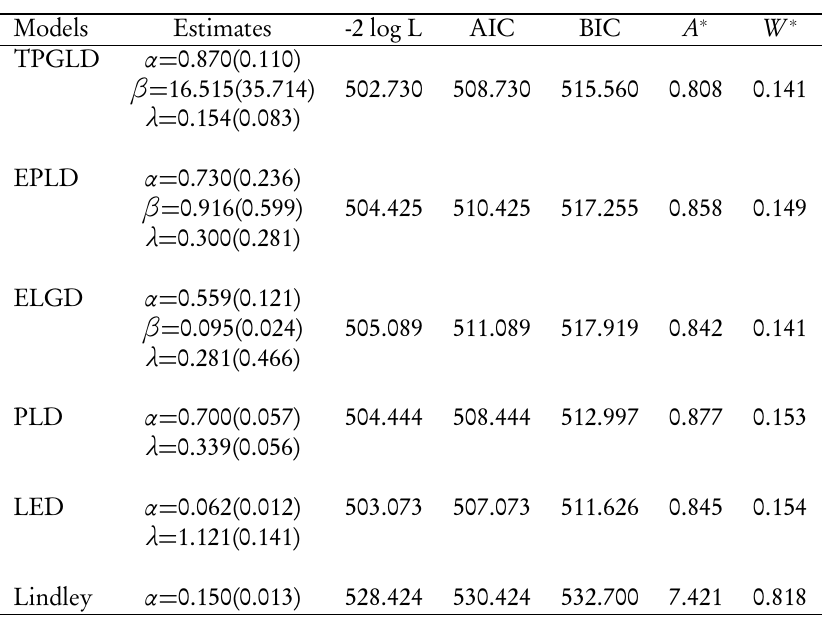
Summary statistics for the data set 1 (standard error in parenthesis).